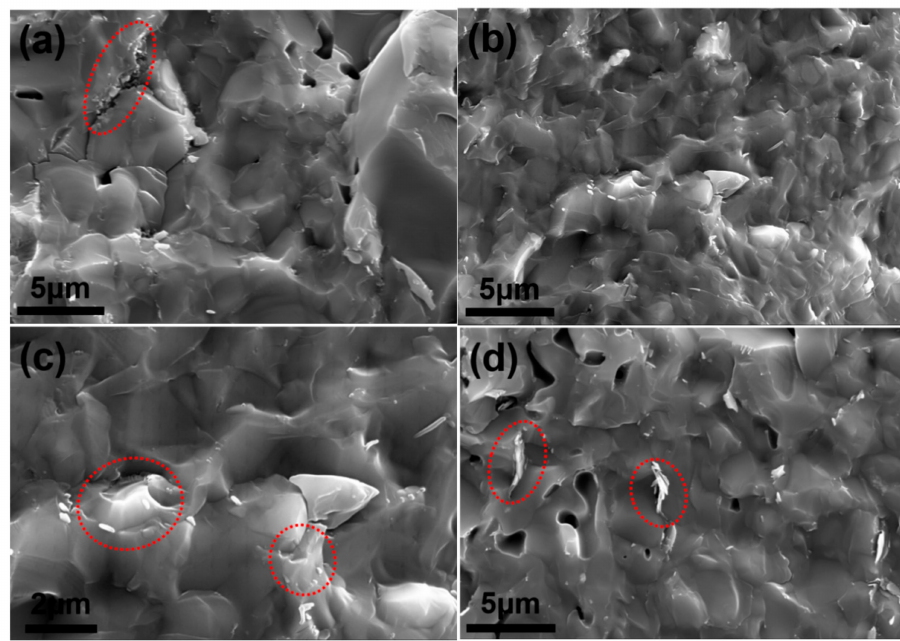
Figure 7. SEM images of fracture surface, ( a ) S2; ( b , c ) S3; ( d )